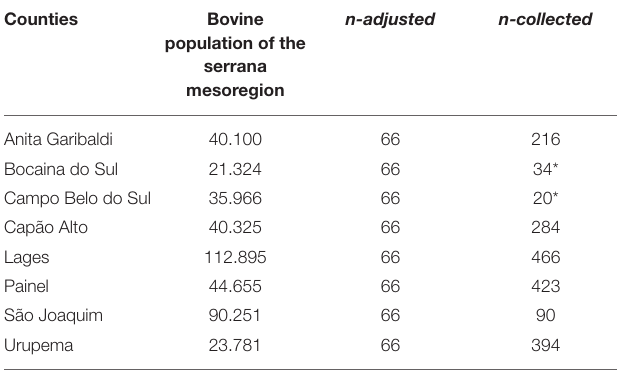
TABLE 1 | Sample calculation based on the bovine population in eight municipalities in the Serrana Mesoregion. Counties n-collected